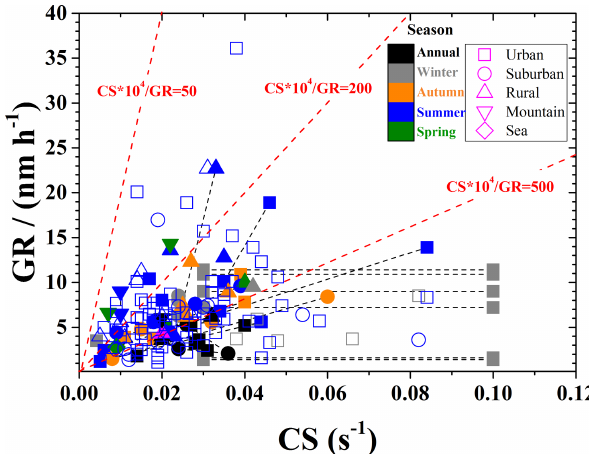
Figure 5. Particle GR as a function of CS in the NPF events in China. The solid points are average data for a certain observation period, while the open points are data for individual NPF days. The line between two data points indicates that a range of GR and/or CS was reported in the literature. The data are collected in the refer- ences in Table